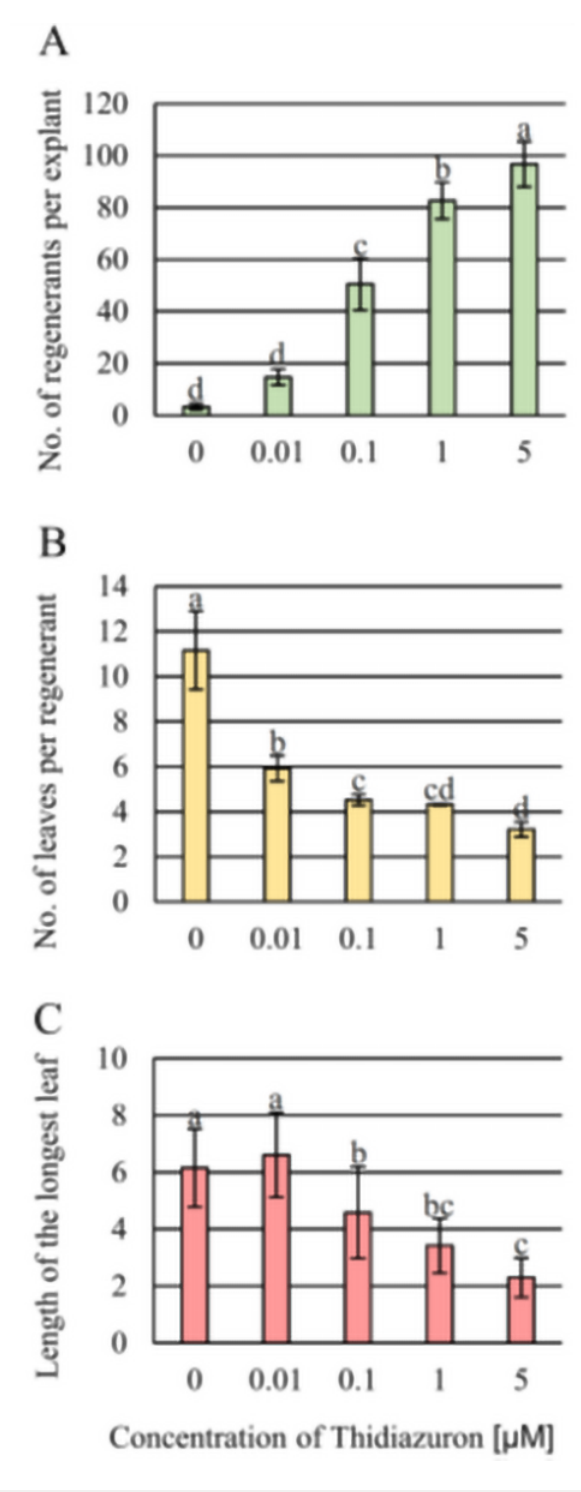
Figure 4 Growth and development of regenerants in post thidiazuron [TDZ; 1-phenyl-3-(1,2,3-thiadiazol-5-yl)-urea)] treatment of the apical dome on 1/2 Murashige and Skoog hormone-free medium considering: ( A ) number of regenerants per explant, ( B ) number of leaves per regenerant, and ( C ) length of the longest leaf (cm) of the regenerant. Mean ± standard deviation marked by different letters are significantly different ( p ≤ 0.05) according to Tukey’s post hoc